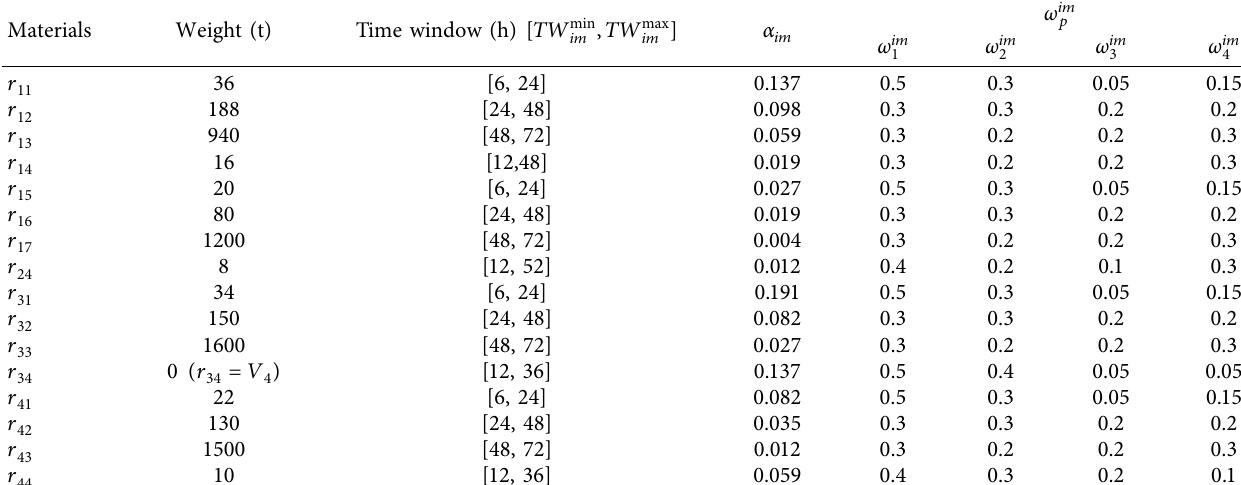
Table 2: Information on materials.